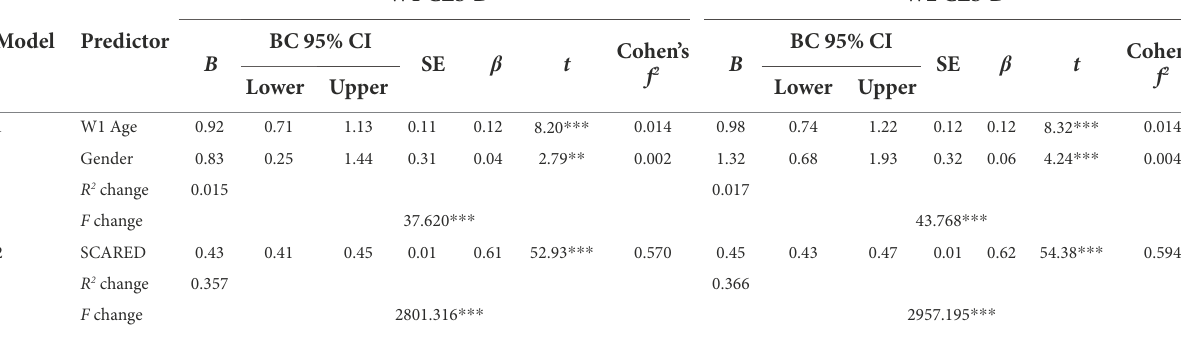
TABLE 4 Longitudinal predicting effects of anxiety (SCARED) on depression (CES-D) and its change.